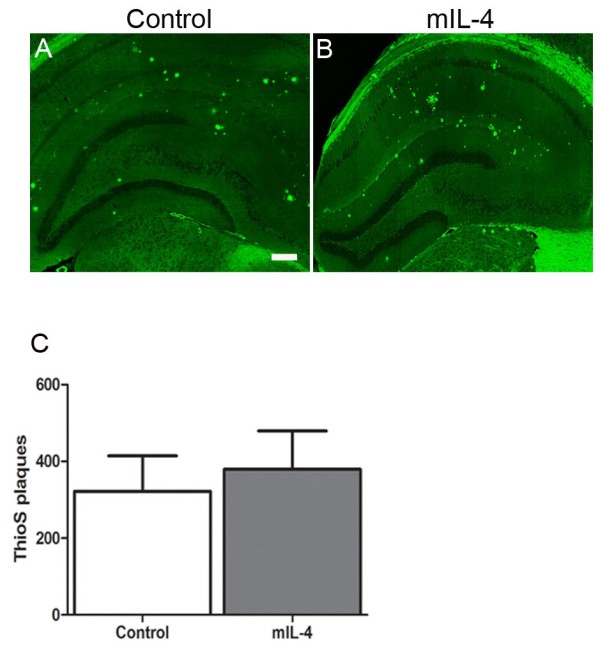
No significant change in cored plaques seen in AAV1-mIL-4 expressing TgCRND8 mice. A-B. Representative fluorescent images of Thioflavin S stained hippocampi from 5.5 month old TgCRND8 mice injected with rAAV2/1 mIL-4 (B) or rAAV2/1-EGFP (Control). Scale Bar, 200 μm. C. A comparison of the total number of Thioflavin S stained “cored” plaques from the forebrain of 5.5 month old TgCRND8 mice injected with rAAV2/1 mIL-4 or rAAV2/1-EGFP is depicted. Data represents mean ± sem. (n = 5/group; p = 0.0542, t test).